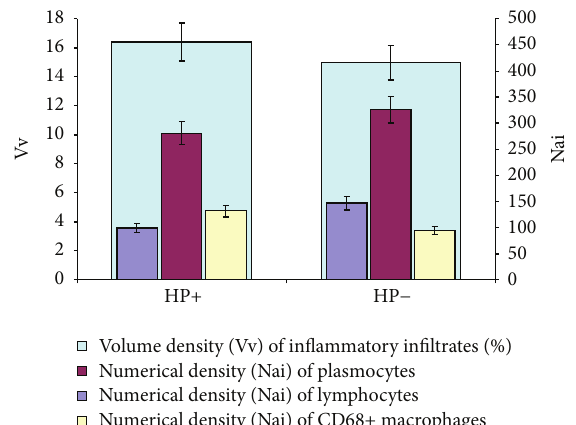
Figure 3: Volume density (Vv) of inflammatory infiltrates and numerical density (Nai) of lymphocytes, plasmocytes, and CD68+ macrophages study results.